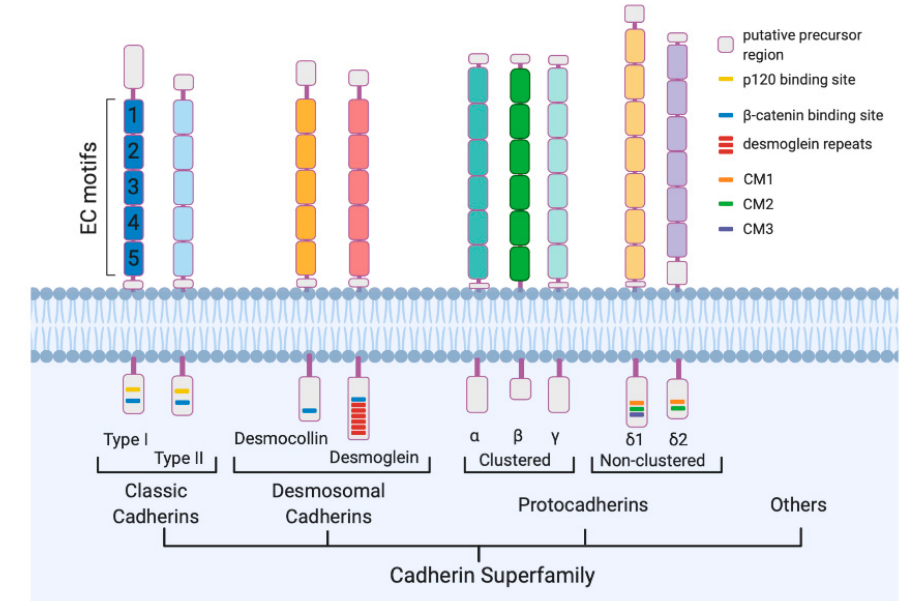
Figure 1. Cadherin superfamily. Schematic drawing of representative members of Classic Cadherins, Desmosomal Cadherins, and protocadherins. All the proteins share “Cadherin motifs” or extracellular cadherin (EC) motifs at their extracellular domain. The number of EC motifs varies from one subfamily to another. The cytoplasmic sequences are conserved only among the members of each family or